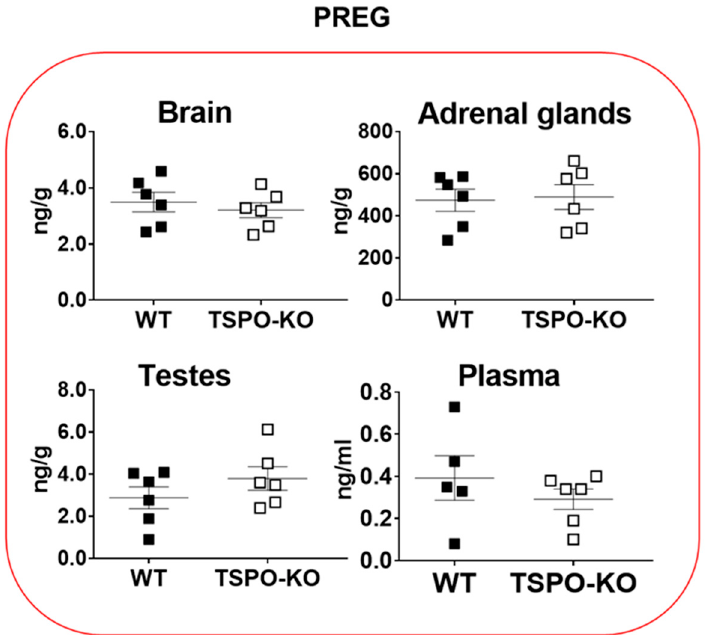
Figure 2. Concentrations of PREG in tissues of male WT and TSPO-KO mice analyzed by GC-MS/MS as described in the Material and Methods section. Data are expressed as means ± SEM and were analyzed by unpaired t -test ( n = 5–6).